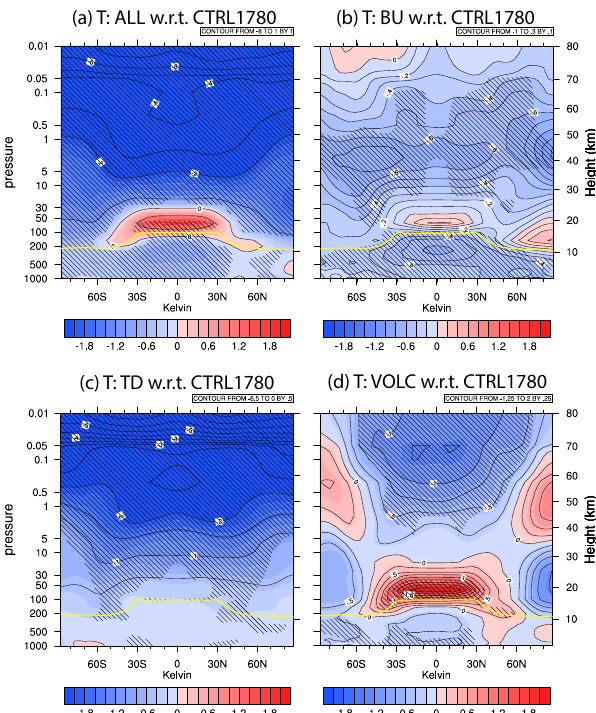
Fig. 7. Absolute differences in temperatures of the DM-ALL, DM- BU, DM-TD and DM-VOLC experiments with relation to the DM- CTRL1780 forcing run. Hatched areas are significantly different on a Student’s t test with α = 5%. The yellow line illustrates the WMO tropopause